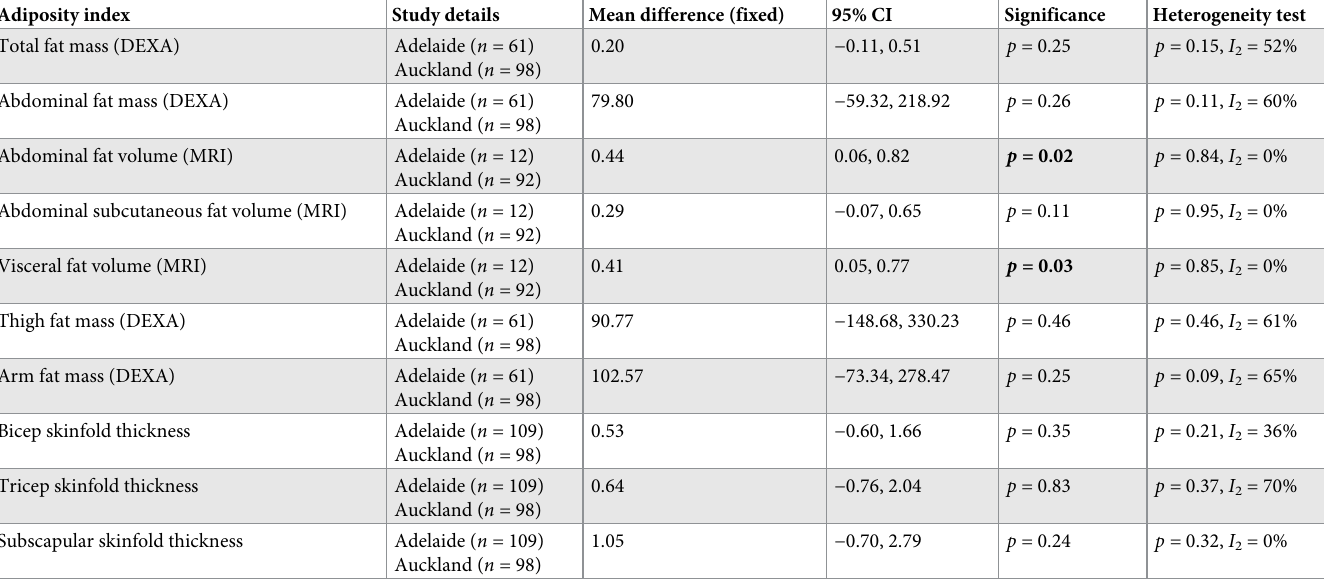
Table 1. Childhood adiposity